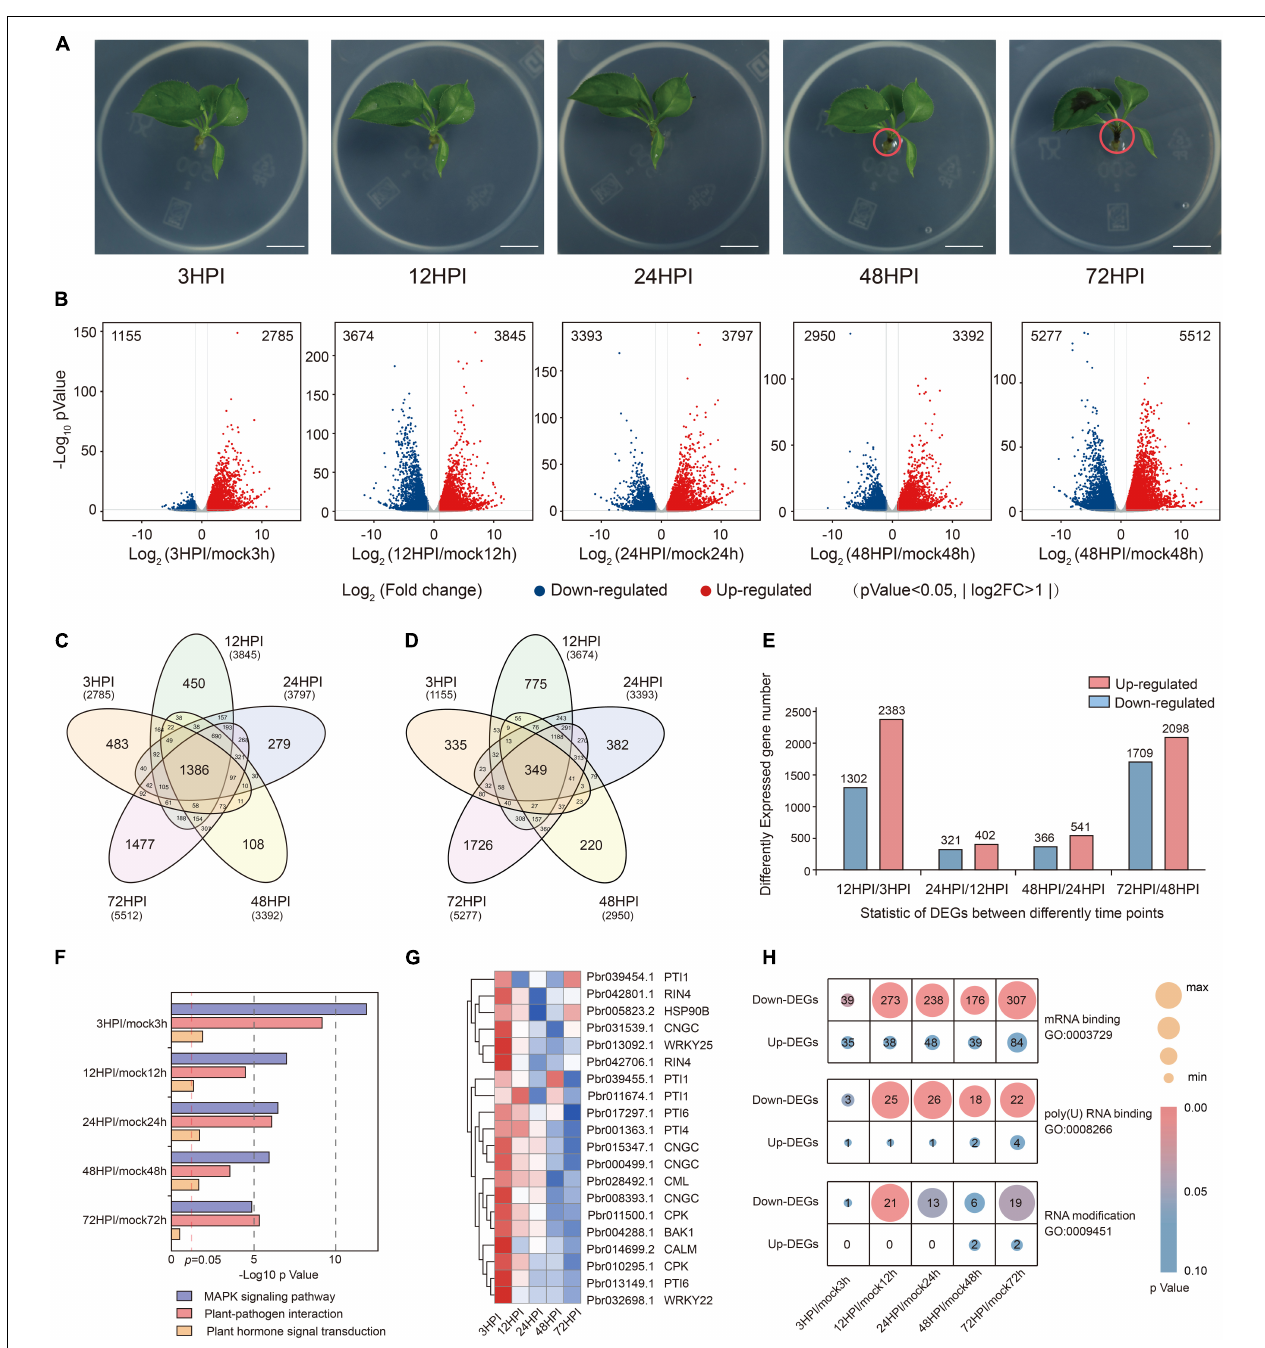
FIGURE 1 | Significant changes in transcription levels after fire blight inoculation. (A) Images of pear seedlings after fire blight inoculation at 3 HPI, 12 HPI, 24 HPI, 48 HPI, and 72 HPI. Scale bar = 1 cm. (B) Volcano plot of DEGs (differentially expressed genes) between Erwinia amylovora –inoculated and mock-inoculated at different time points. (C,D) Venn diagram showing the number of DGEs identified between Erwinia amylovora –inoculated and mock-inoculated at different time points. (C) Upregulation. (D) Downregulation. (E) The bars indicate the number of DEGs between samples from adjacent time points, red indicates upregulation, and blue indicates downregulation. (F) KEGG pathway analysis of upregulated genes in plant hormone signal transduction, plant–pathogen interaction, and MAPK signaling pathway. (G) Expression profiles of DEGs related with plant–pathogen interaction pathway. (H) Gene number of DEGs involved in GO term mRNA binding (GO:0003723), poly(U) RNA binding (GO:0008266), and RNA modification (GO: 0009451).